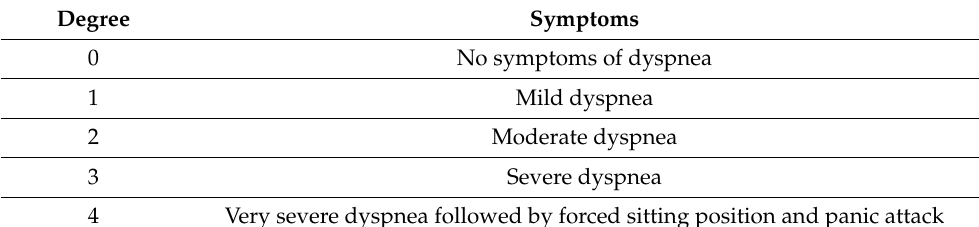
Table 2. Modified Borg acute dyspnea